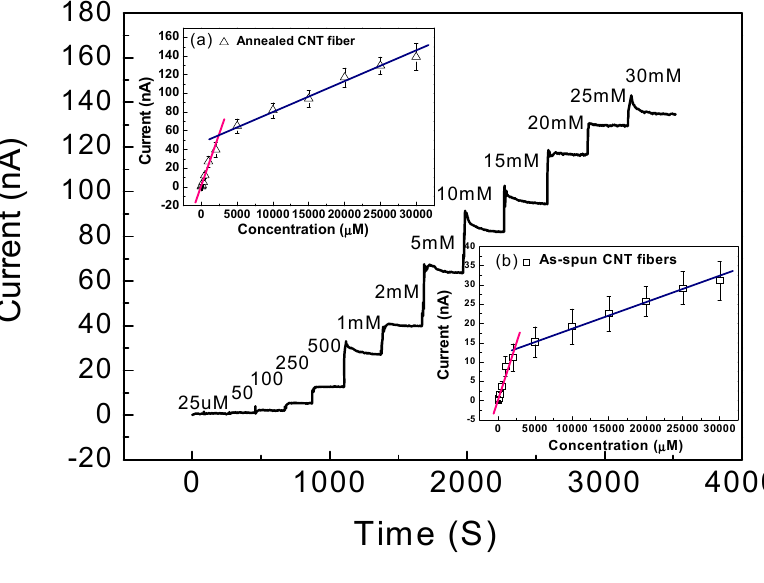
Figure 6. Amperometric responses of CNT fiber biosensors with 30 nm gold film coating. Numbers in the chart represent the corresponding glucose concentration of the